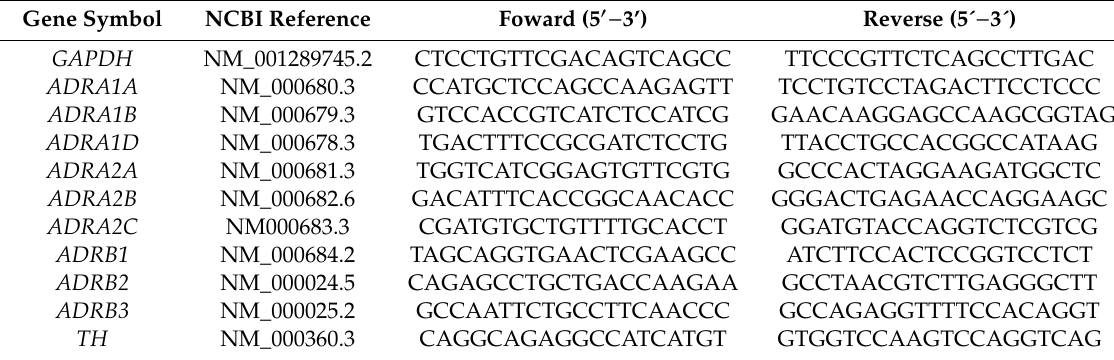
Table 3. The primers used for